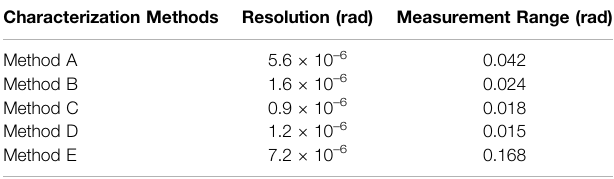
TABLE 1 | Comparison of the measurement effects of various characterization schemes. Characterization Methods Resolution (rad) Measurement Range (rad) Method A